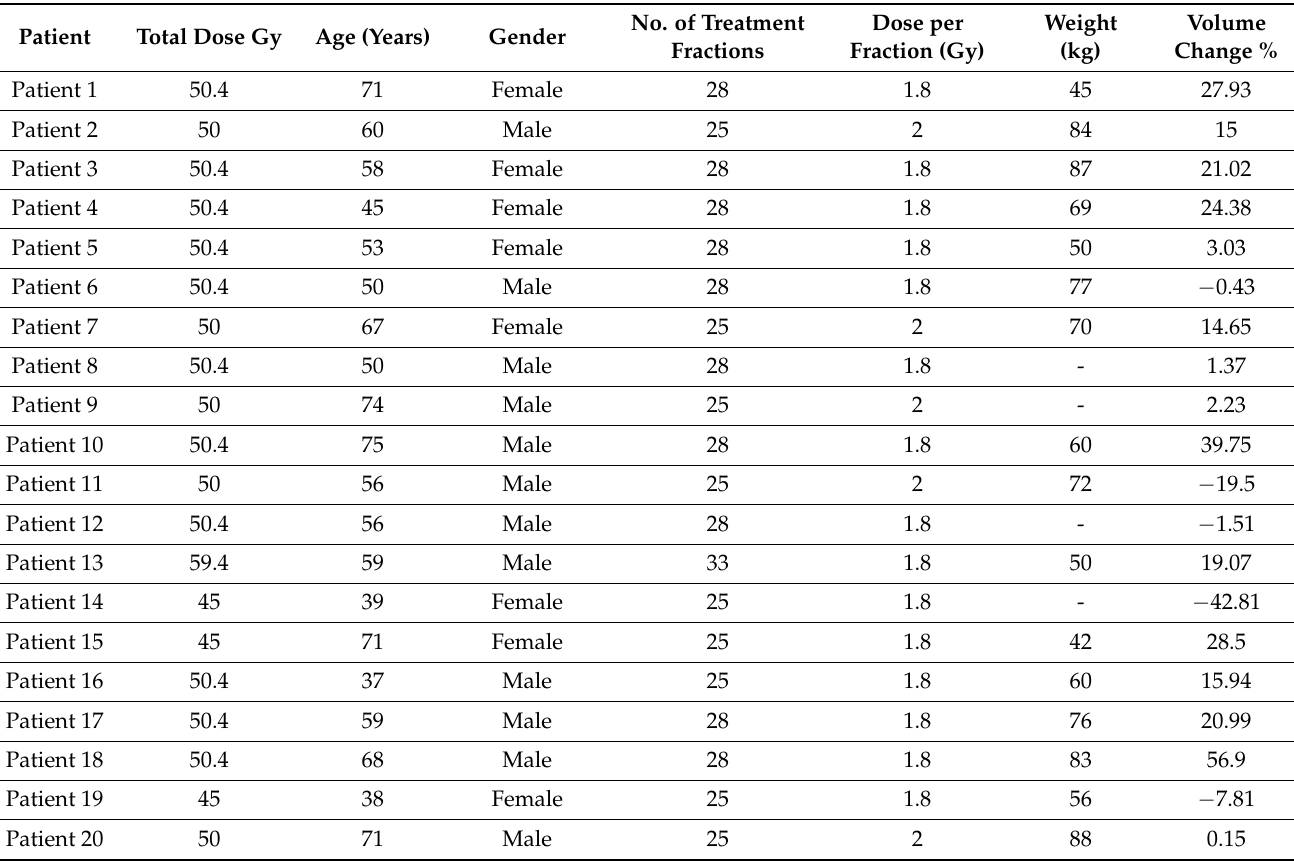
Table 2. Tumor volume change for all